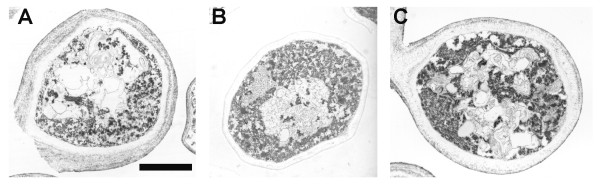
Representative transmission electron micrographs of W. dermatitidis strains A] 8656, B] wdpks1Δ-1, and C] wdpks1Δ-1-501 grown for 7 days in YPD medium at 37°C. Scale bar, 2 μm.